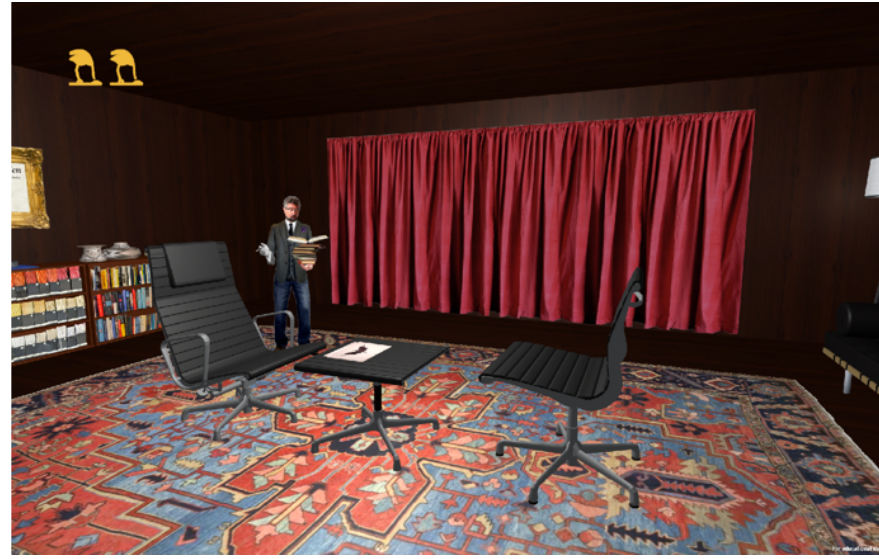
Figure 10. Still from Psychasthenia 3: Dupes . Courtesy of the authors.